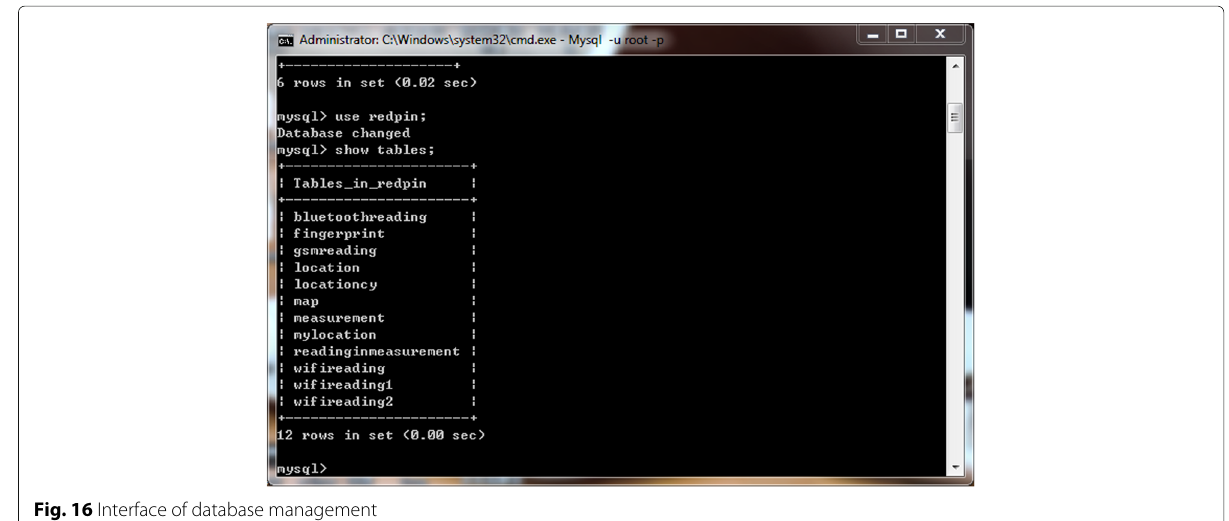
Fig. 16 Interface of database management